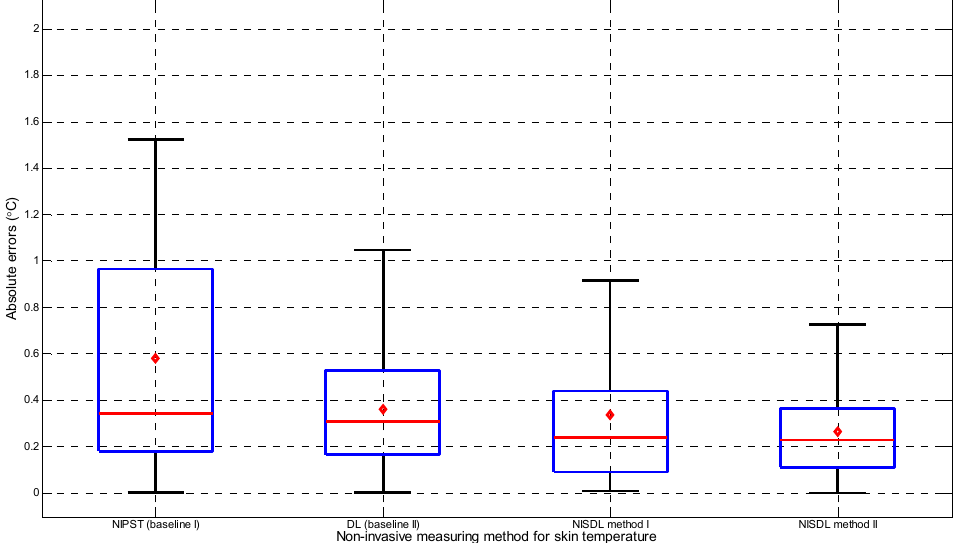
Figure 4. Error statistics (box-whisker plot) comparison between baseline and NISDL ( a ). NIPST was published in references [21]. ( b ). Skin images were trained directly by DenseNet201 to obtain a model and predict skin temperature, and SSI was not involved. ( c ). NISDL method I and NISDL method II all belong to NISDL. The main difference is that SSI values and skin images are combined at different times.